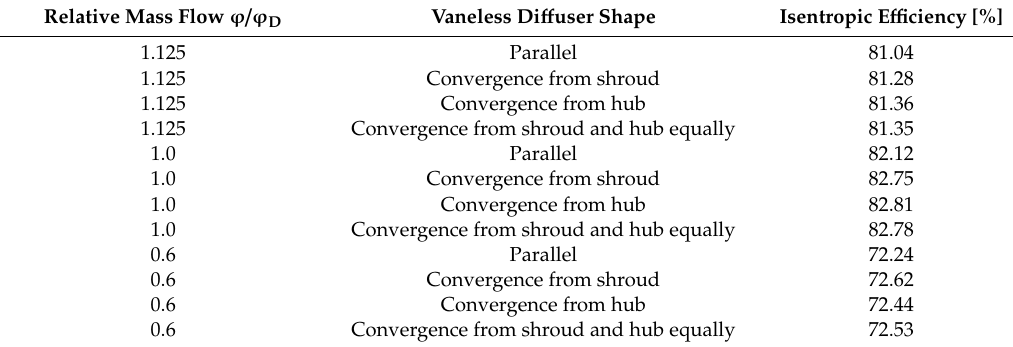
Table 5. Centrifugal compressor isentropic e ffi